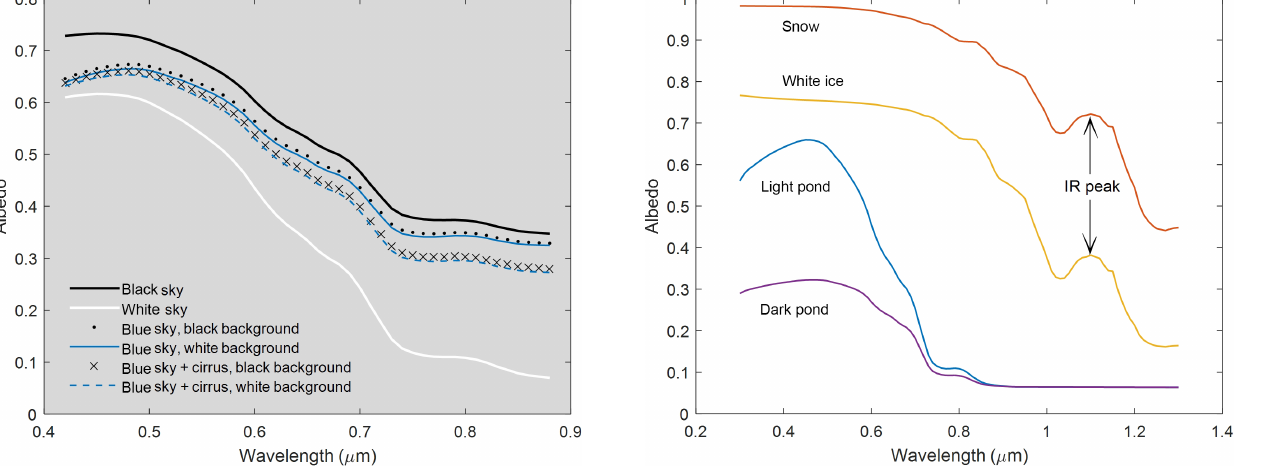
Figure 4. Modeled spectra of melt pond albedos at various sky con- ditions and background albedo at sun elevation 10 ◦ .